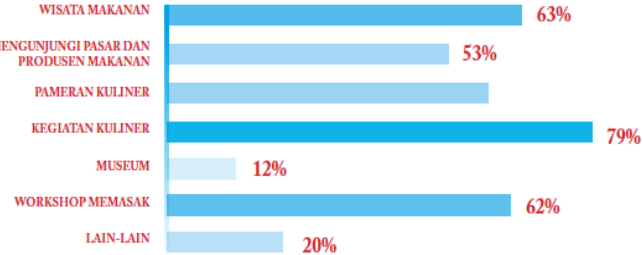
Figure 1. Motivation to Visit Culinary Tourism